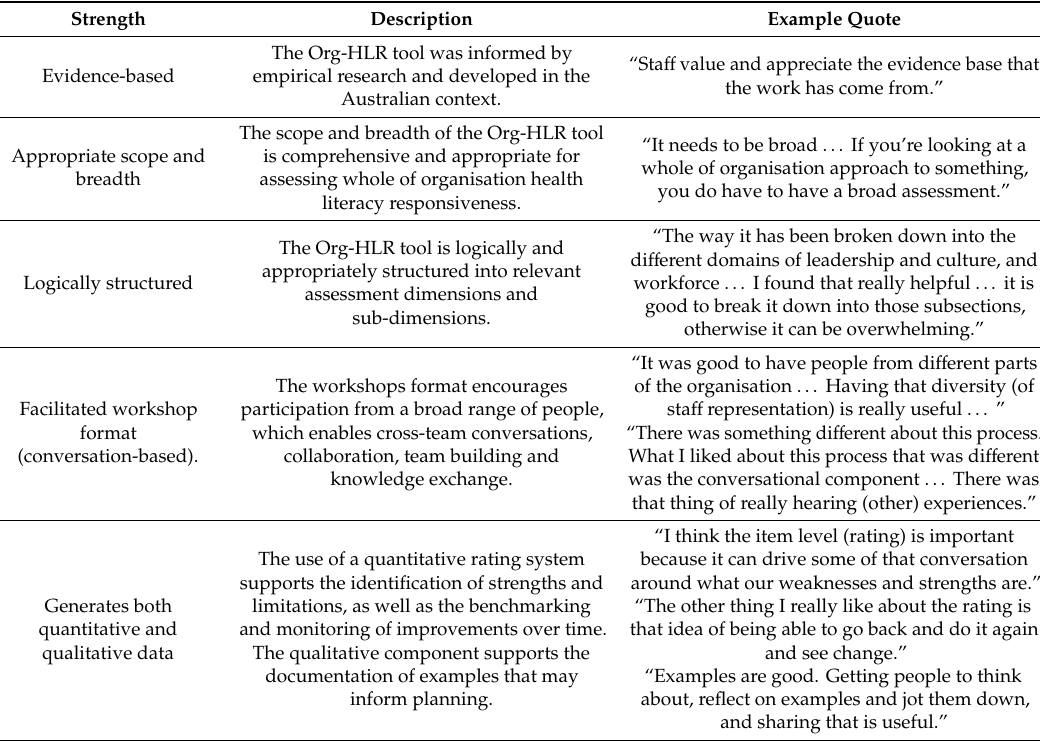
Table 3. Perceived strengths of the Org-HLR tool and